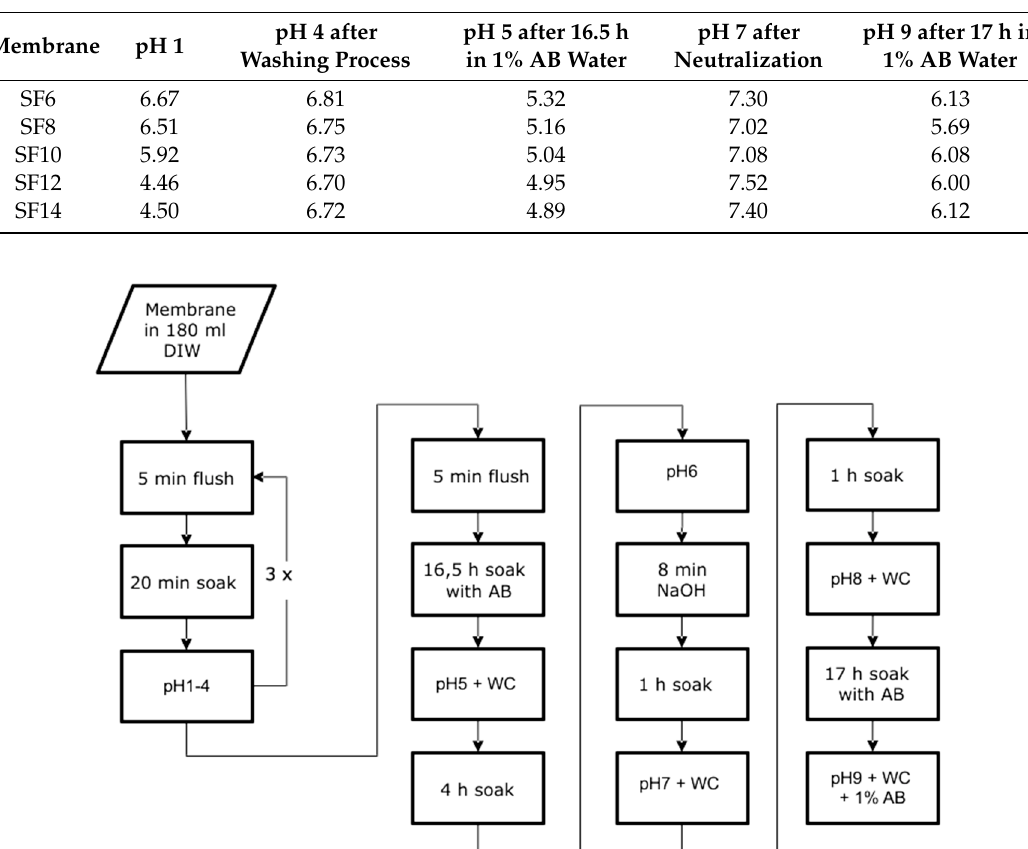
Figure 1. Flow chart depicting the washing and pH neutralization process for post-treatment during membrane production. DIW = Deionized water. AB = 1% Antibiotic (Pen Strep (Gibco Life Technologies, Carlsbad, CA, USA) with 10.00 units/mL Penicillin and 10.00 μ g/mL Streptomycin). WC = Water change. Flush = Flush under running distilled water. Soak = Leave in 180 mL deionized water. pH = Measure pH value while stirring for 5 min. NaOH = Leave in 0.01 M NaOH solution.